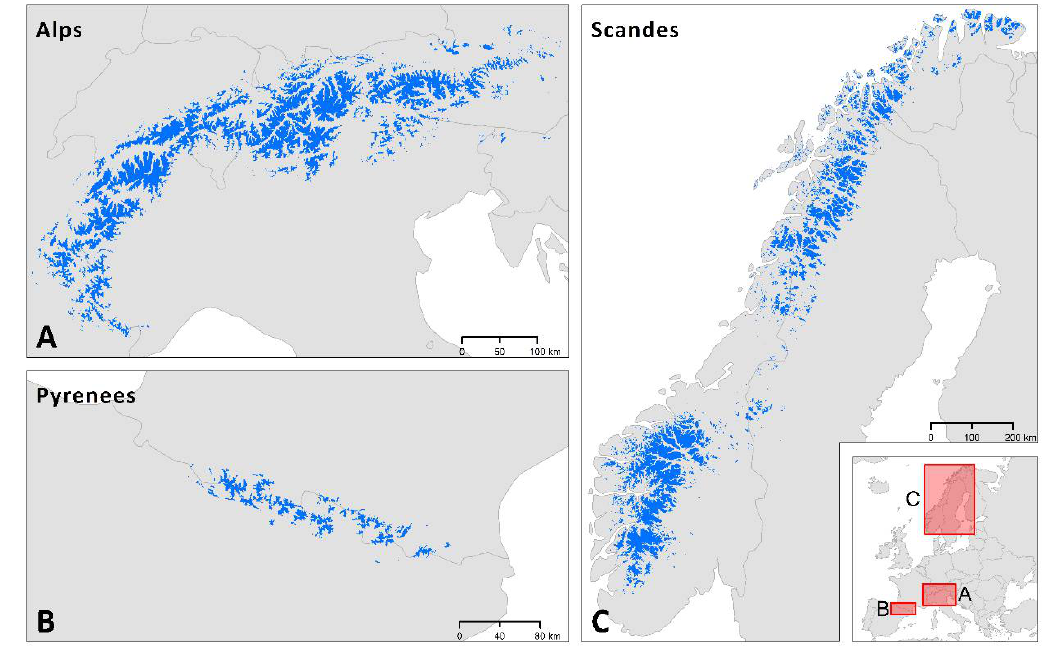
Figure 1. Extent of the alpine tundra domain (ATD) according to the Köppen-Geiger definition using CHELSA data [39] in the reference period (1981–2010) in the Alps, Scandes and Pyrenees. Note the different scale in the boxes.